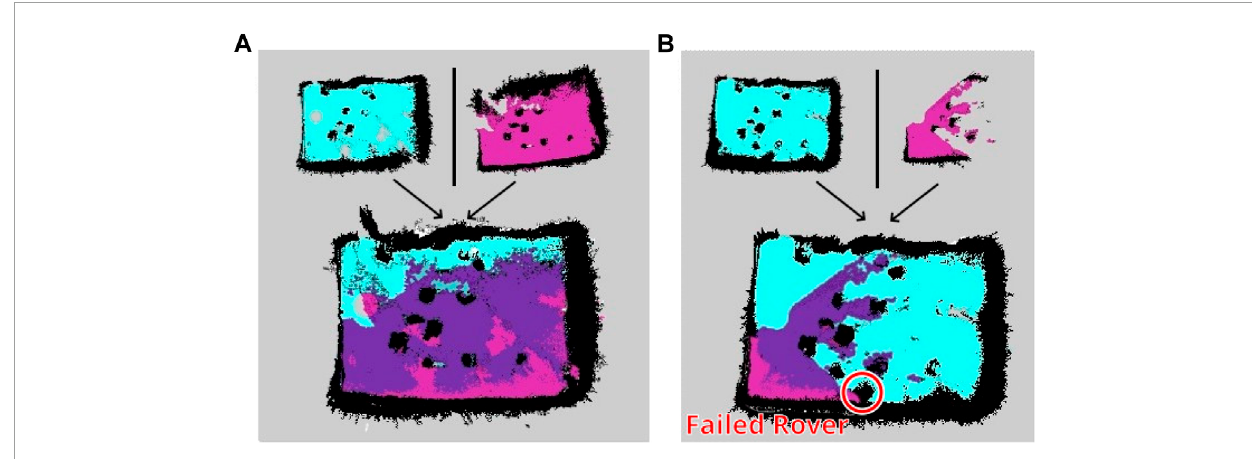
FIGURE 12 Mapping of the LunaLab done by two REALMS rovers in two different cases. (A) Two rovers successfully map a shared environment and merge their maps. (B) Two rovers mapping a shared environment with one rover failing in the process and the other taking over the area.